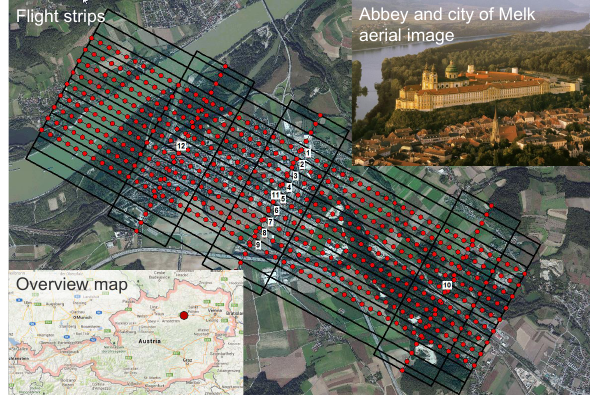
Figure 4. Study area city of Melk (Austria), center: planned flight trajectories (black lines) and camera positions (red circles), upper right: aerial image of the abbey and city of Melk, bottom left: location of study area (red circle) within Austria was chosen because it contains different types of landscape com- prising deciduous and coniferous forests, cropland, water bodies, as well as suburban and urban areas, including the challenging narrow alleys in the historic part of the city of Melk (Figure